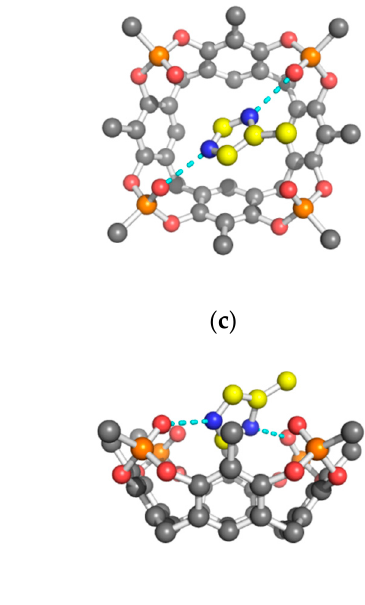
Figure 2. Orthogonal views of the H-bond interactions (cyan dashed lines) between the side chain of Arg amino acid (yellow carbons) and tetraphosphonate cavitand Tiiii (grey carbons) ( a , b ) conformation I; ( c , d ) conformation II. Other atoms color code: P, orange; N, blue; O, red. Hydrogen atoms have been omitted for clarity.